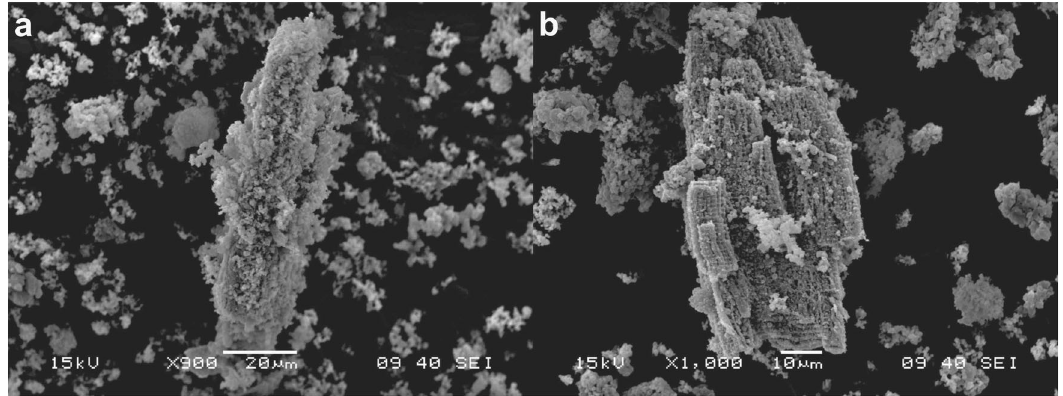
Fig. 5 SEM images of ARVC cultured with PPPyN after 30 days of culture. a ARVC with PPPyN on its surface. b Group of aligned